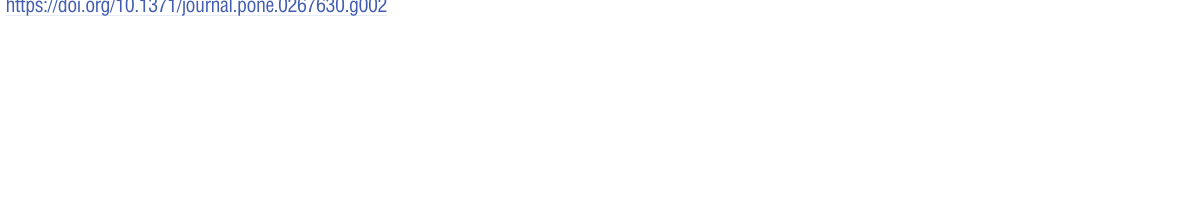
PLOS ONE | https://doi.org/10.1371/journal.pone.0267630 May 3,